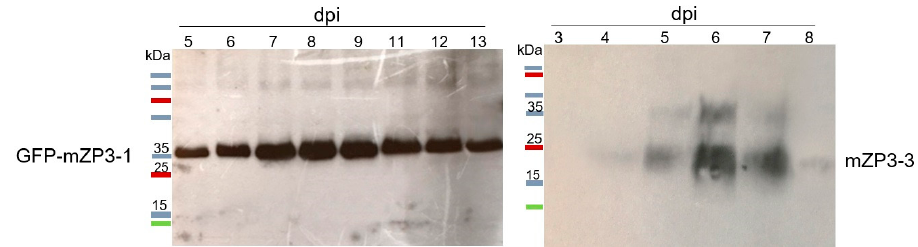
Figure 2. Western blot of N. benthamiana crude leaf extracts to detect protein expression and to determine the optimal harvest time. Expression of GFP-mZP3-1 ( left ) and mZP3-3 ( right ) in the infiltrated leaves, detected by western blot of 30 µ g TSP, probed with anti-His monoclonal antibodies. dpi, days post-infiltration. Blots cropped for clarity, for uncropped blots see Figure S3.